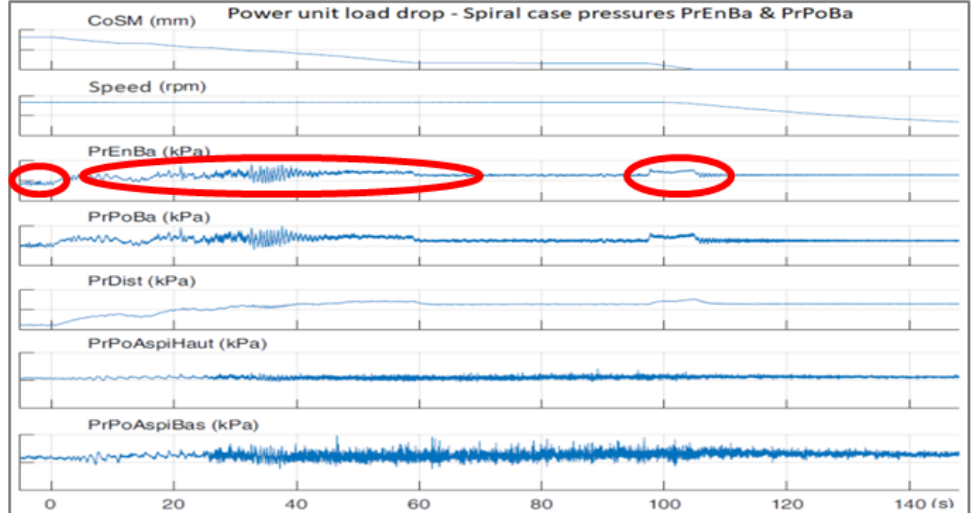
Figure 8. Pressures in time during a power load drop, tests performed in 2019 in hydropower plant equipped with high-head Francis turbines [88].